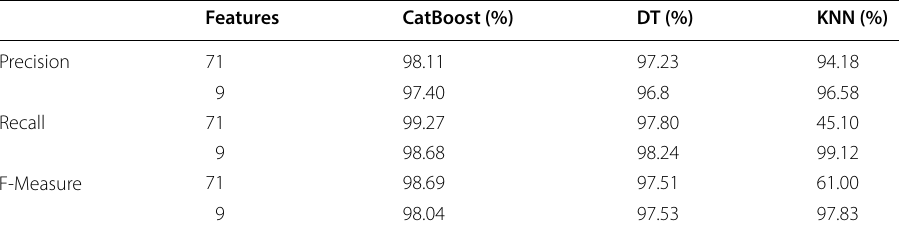
Table 18 From [30], “Precision , recall and F-measure of CatBoost, Decision Tree classifier and KNN for 9 and 71